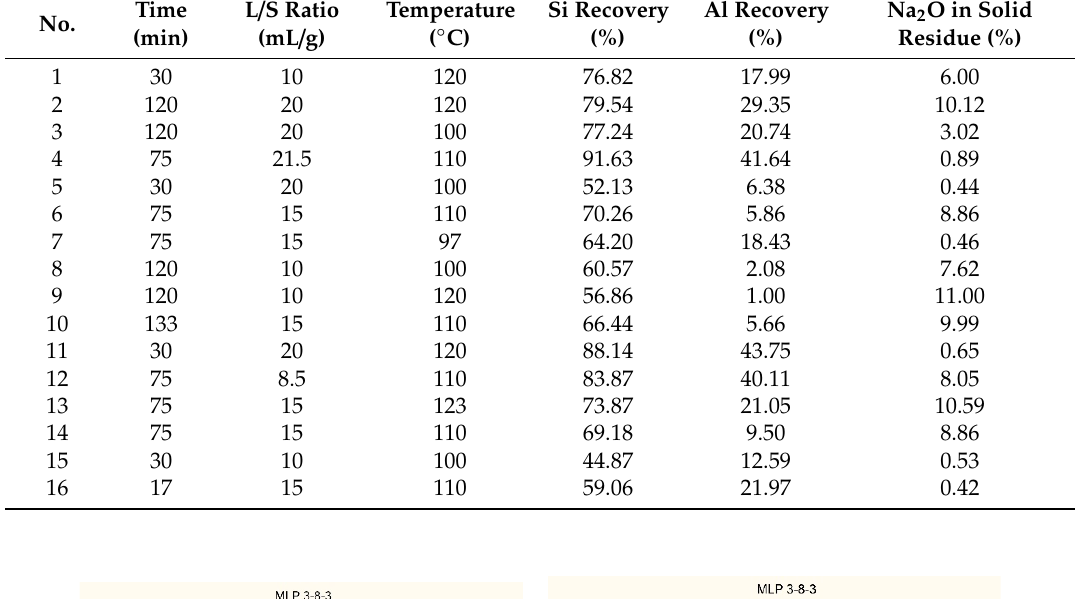
Table 4. The matrix for planning experiments and the results obtained on the leaching of aluminum and silicon into liquor and the sodium content in the solid residue of CFA.